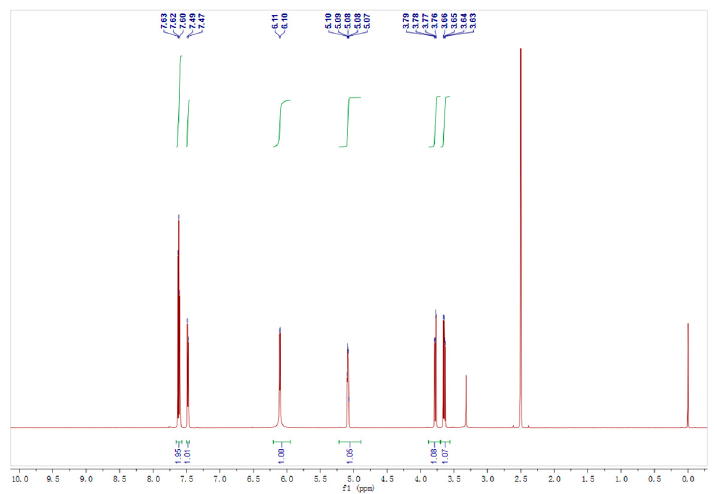
Figure 4. The 1 H NMR spectrum of the product.